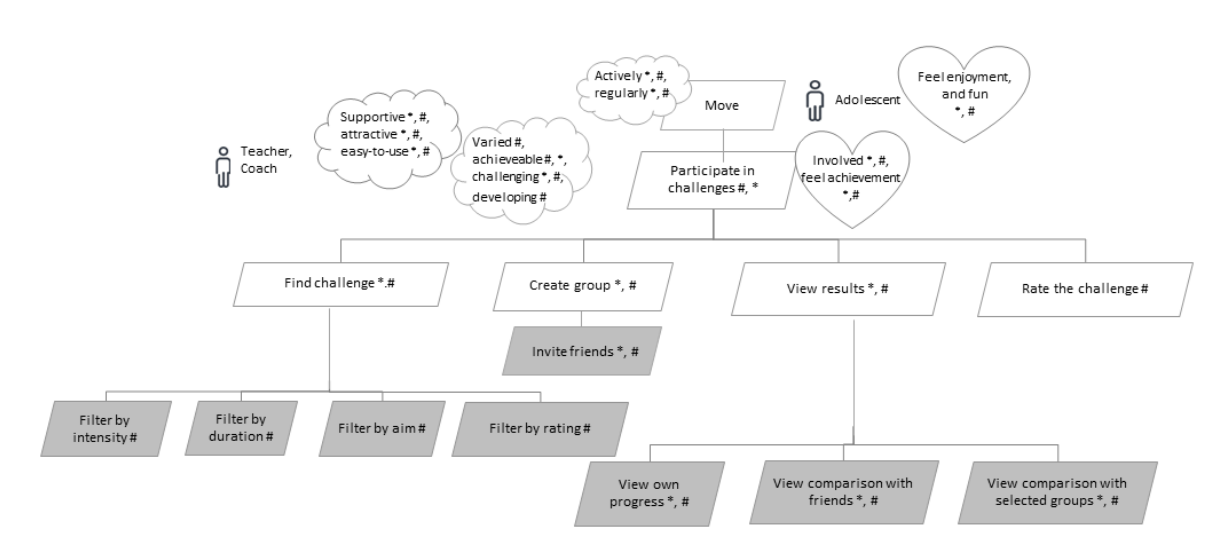
Figure 4. Sublevel models for the functional goal “participate in challenges.” The “*” in the model represents findings from the literature; the “#” represents suggestions by experts; gray rectangles represent functionalities at the level of user